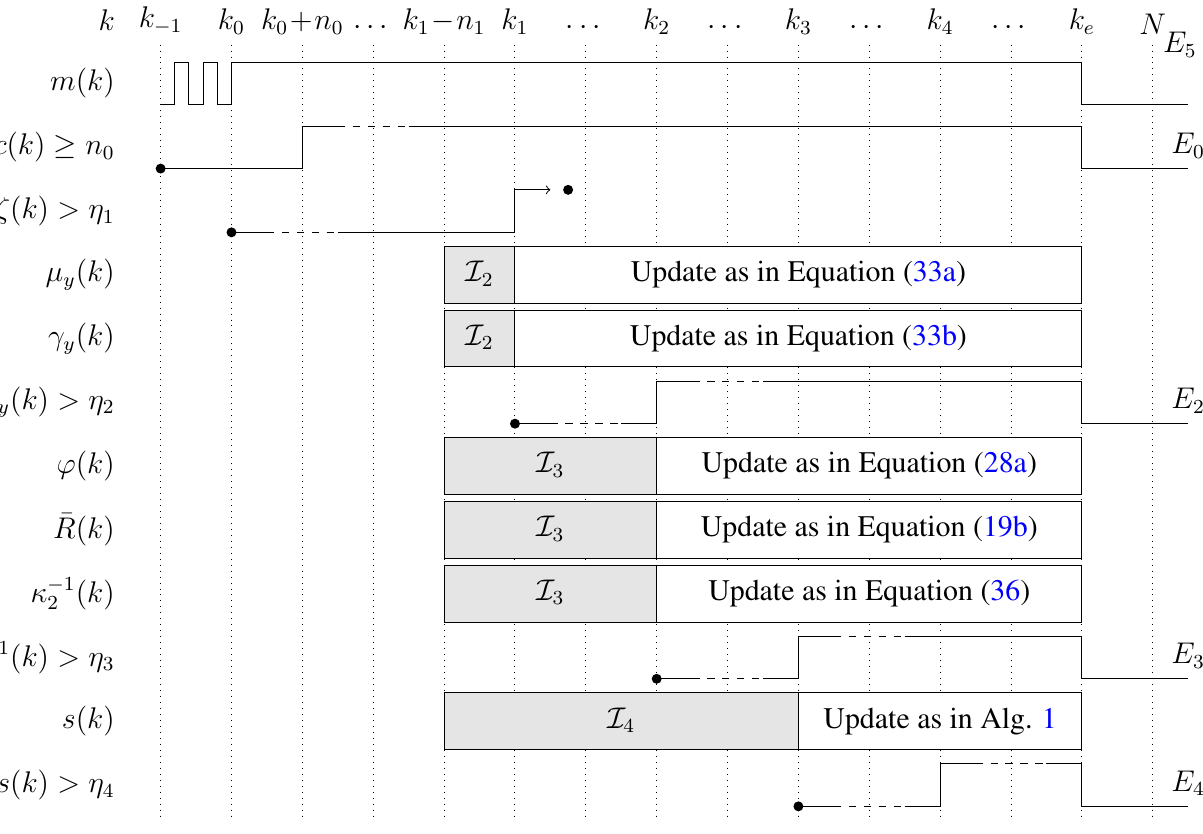
Figure 2. Algorithm execution sequence. Lines denote the different logical tests. Boxes relate to the computations of quantities used in the different tests. Shaded boxes denote the samples used during initialization of the different quantities and white boxes refer to their online